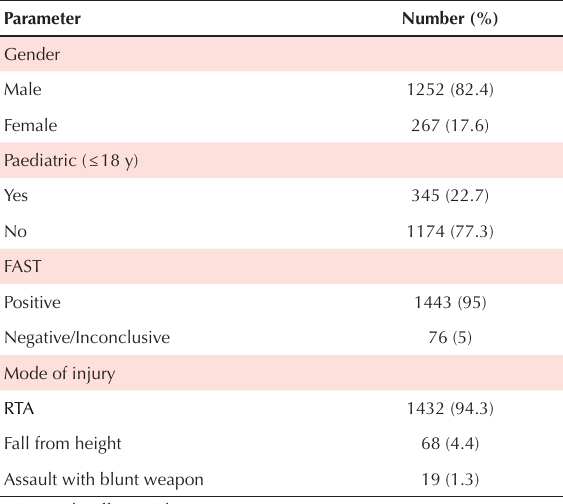
Table 1. Demographic information of the patients